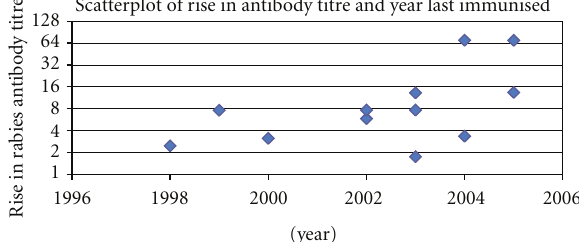
Figure 3: Scatter plot of rise in antibody titre and year last